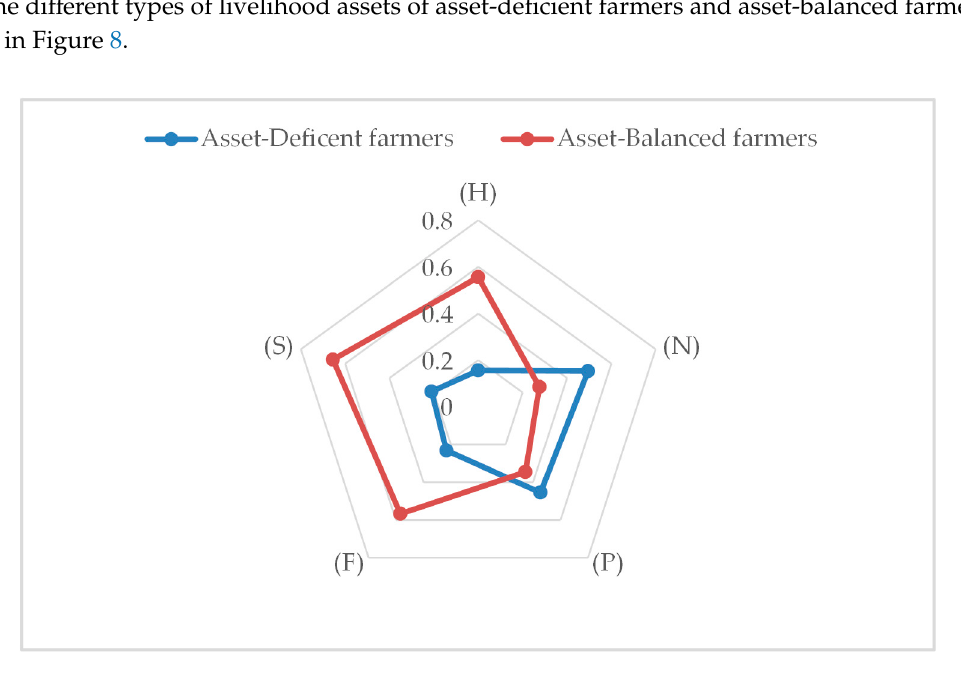
Figure 8. Status quo of land-lost farmers’ households under different livelihood asset allocations.